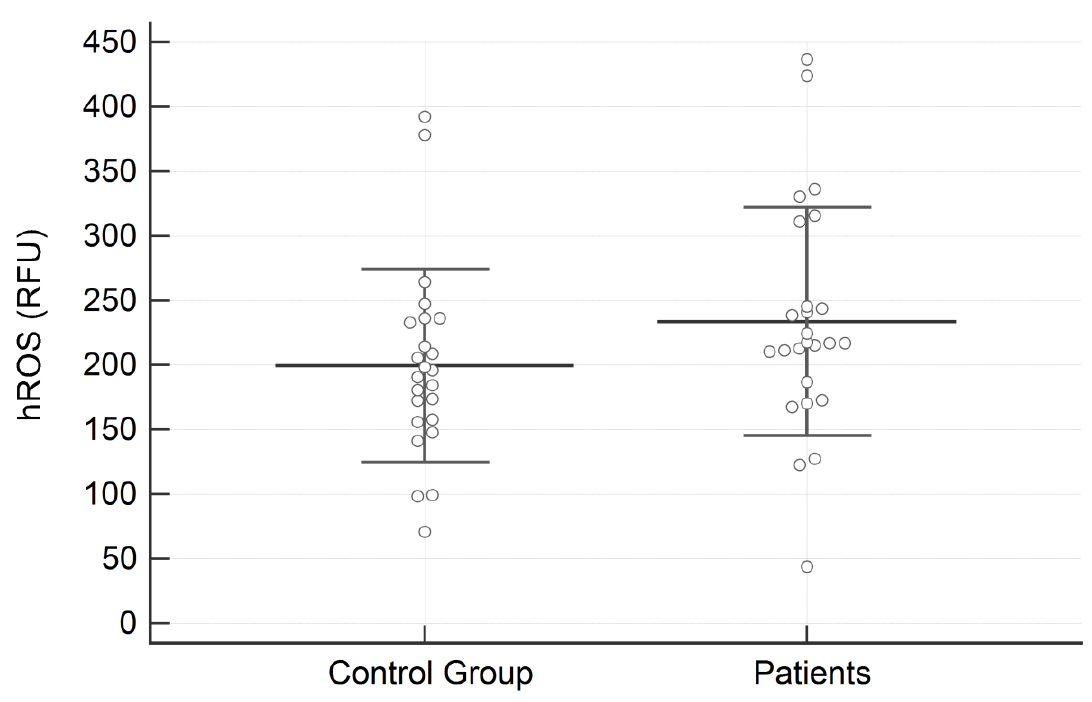
Figure 2. Results of the high reactive oxygen species (hROS) expressed in RFU in the two examined groups. Data are reported as Mean ± SD.